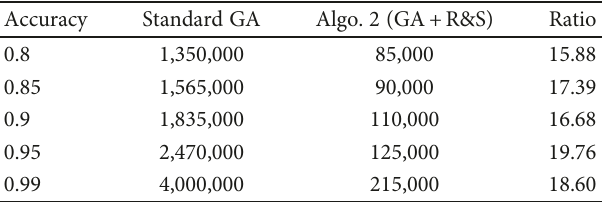
Table 2: The number of simulation runs required to achieve the speci fi c accuracy for the standard GA and Algorithm 2.